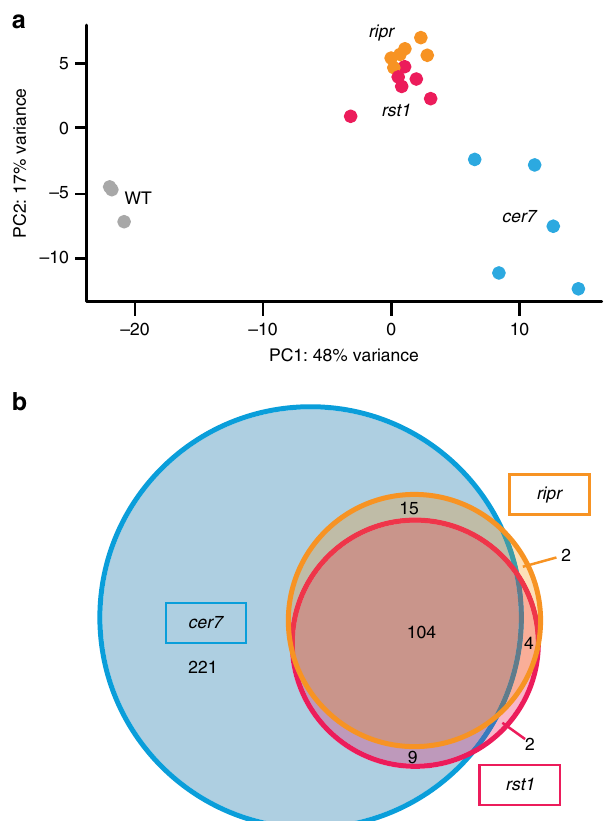
Fig. 8 Loss of RST1 or RIPR results in the accumulation of small RNAs that are also produced in cer7 mutants a Multidimensional scaling plot illustrating global variance and similarities between the 21/22 nt small RNA populations detected in the replicates of WT, cer7 , rst1 and ripr . b Venn diagram showing that rst1 and ripr mutants accumulate quasi identical populations of small RNAs almost all of which are also detected in cer7 mutants. The source data are available in Supplementary Data